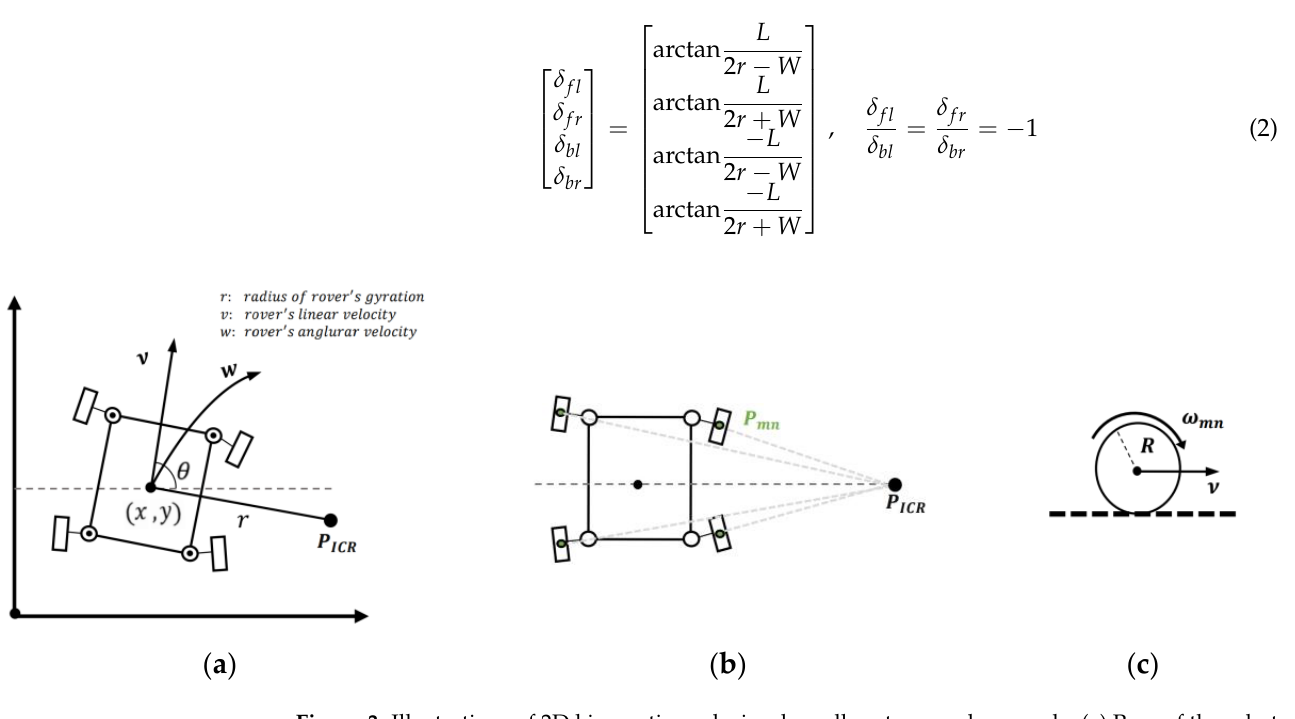
Figure 3. Illustrations of 2D kinematic analysis when all motors work properly. ( a ) Pose of the robot in a 2D Cartesian coordinate system. ( b ) ICR of each wheel under the non-lateral slip condition. ( c ) Side view under the pure-rolling condition.